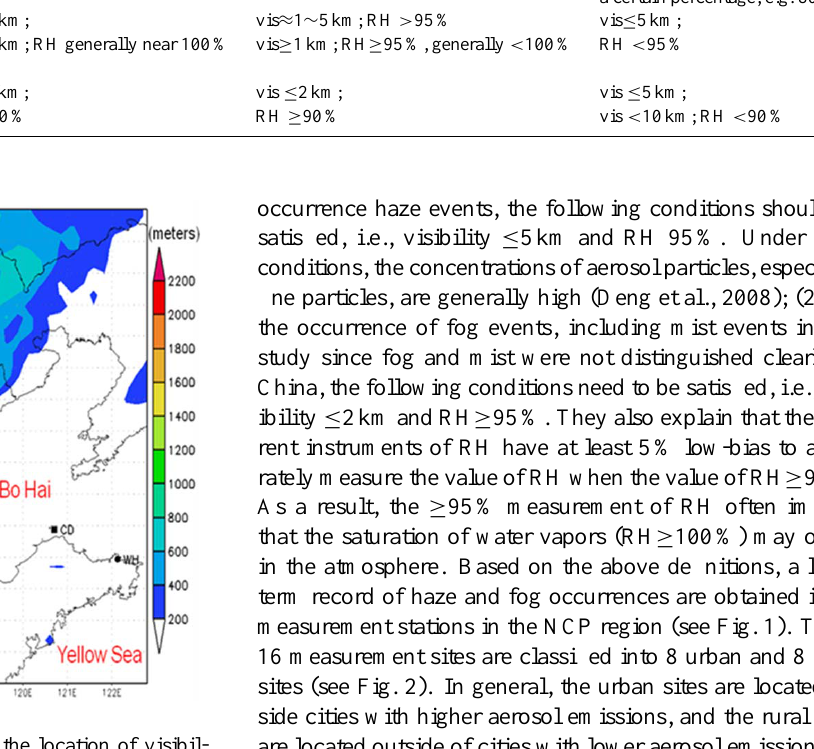
Fig. 1. The topographic map of NCP and the location of visibil- 582 ity observation sites, location of the 16 measurement sites (circle- urban; square-rural) and a field experiment station